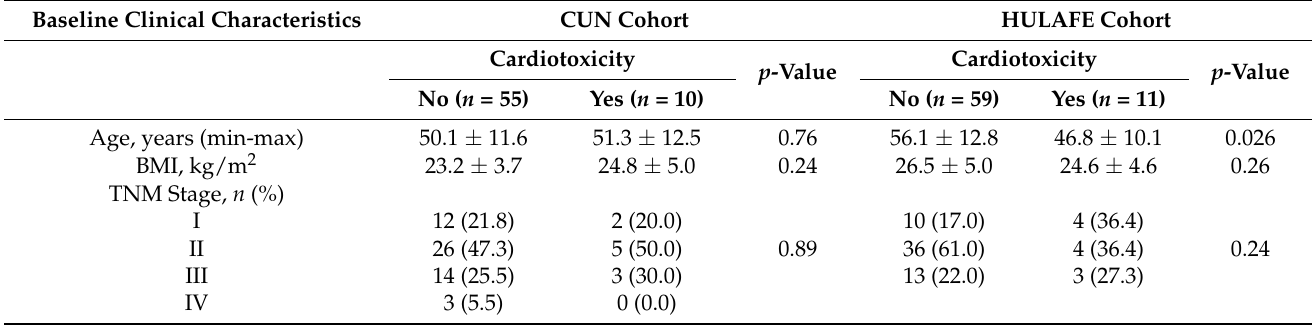
Table 3. Baseline clinical characteristics of BC patients categorized according to the absence or presence of cardiotoxicity at 12 months after completion of ACC therapy.